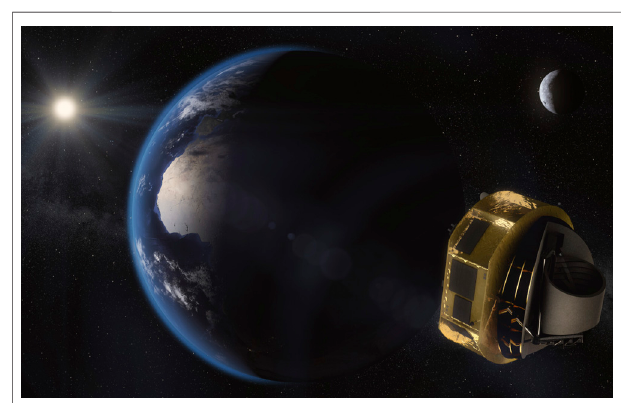
FIGURE 2 | Artist concept of the Ariel space telescope. Image Credit: ESA/STFC RAL Space/UCL/Europlanet-Science Of fi ce.